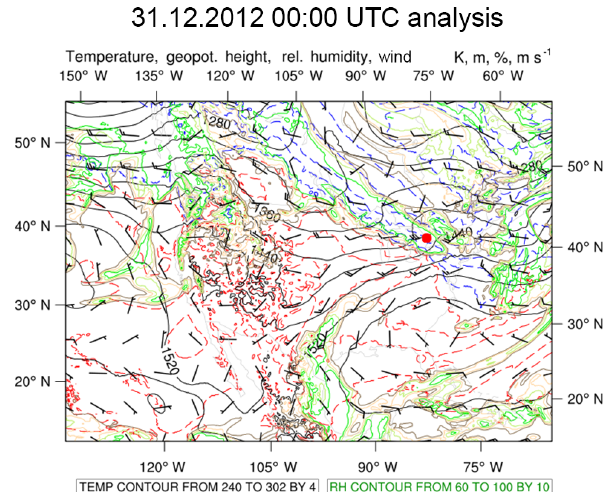
Figure 6. The 00:00UTC, 31 January 2012, 850hPa geopotential heights (m, black solid contours), temperature (K, red: above freez- ing, blue: below freezing), relative humidity (%, green shaded con- tours), and wind (ms − 1 , wind barbs). The red dot in the center right portion of the figure denotes the general location of the GCPEx field